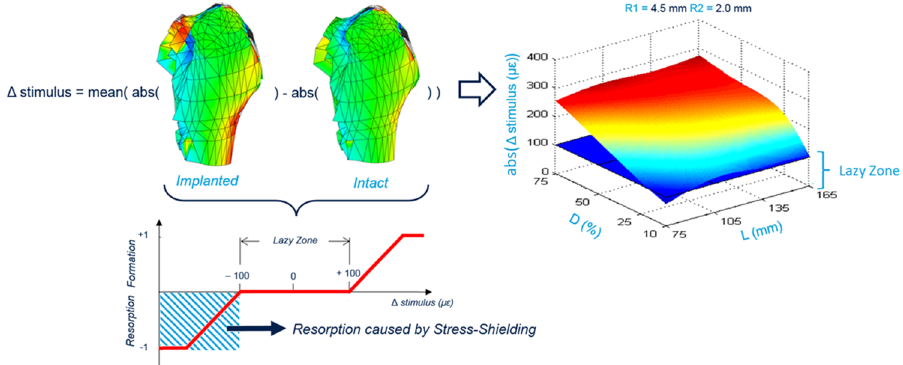
Fig 5. Δ stimulus for the Gruen Zone I and a combination of R1 = 4.5 mm and R2 = 2mm plotted on a 3D surface. Representative plot of the 208 obtained data sets. The results were depictedusing 3D surface plots where the z-axis represents the mean reduction of the strain value in the studied zone (12 sub-zones or Gruen Zone I) after the implantation and the other two axes describe the implantgeometry, in this case, L and D. A threshold plane in blue color is depictedat 100 μ strains[44]. This plane representsthe limits of the lazy zone, where neither resorptionor formation is predicted. To includealso the other two geometry parameters (the radiuses that compose the cross-sectionsurface), it was plotted one graph for each combination of R1 and R2 values. In total, 208 3D surface plots (13 regions x 16 combinations of R1 and R2) were depicted.These 208 plots represent the input and desired output data used to train the